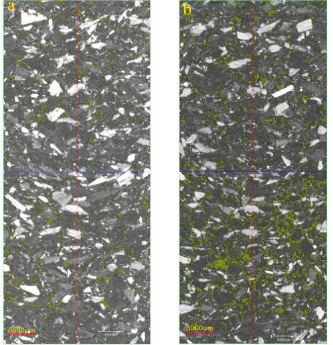
Figure 13. CT scan results. ( a ) Initial sample; ( b ) Failure sample.